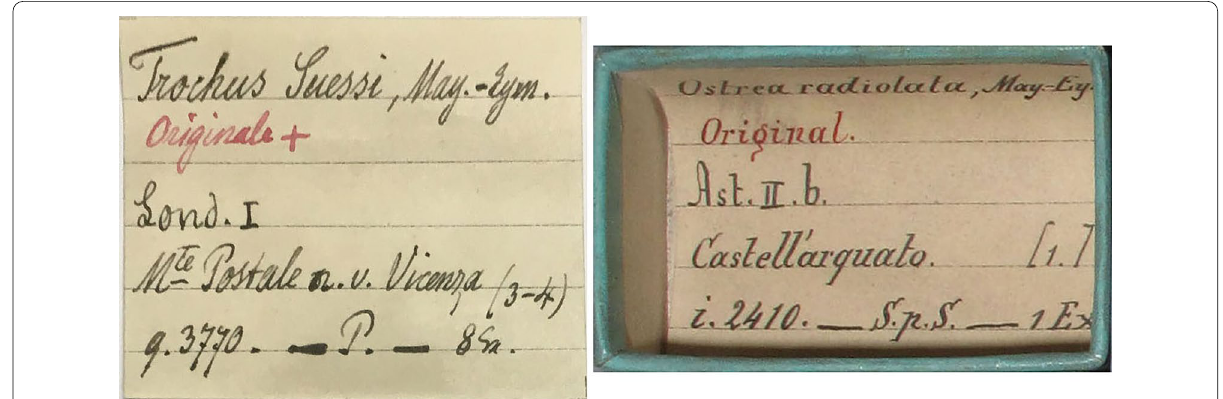
Fig. 10 Two examples of “new” labels: of Trochus suessi Mayer, 1870, and of Ostrea radiolata Mayer-Eymar. Please note that the latter species just appeared in a species list but was never formally described. It is, therefore, a nomen